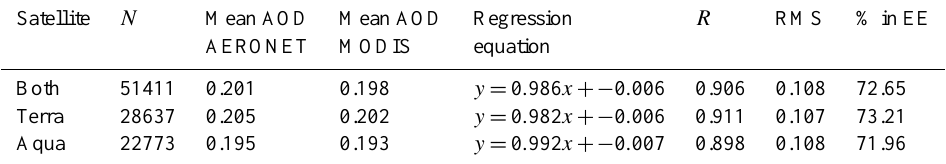
Table 4. Statistics of the comparison between MODIS and AERONET total AOD at 0.55µm over land, (QAC=3) for Terra and Aqua since July 2002.